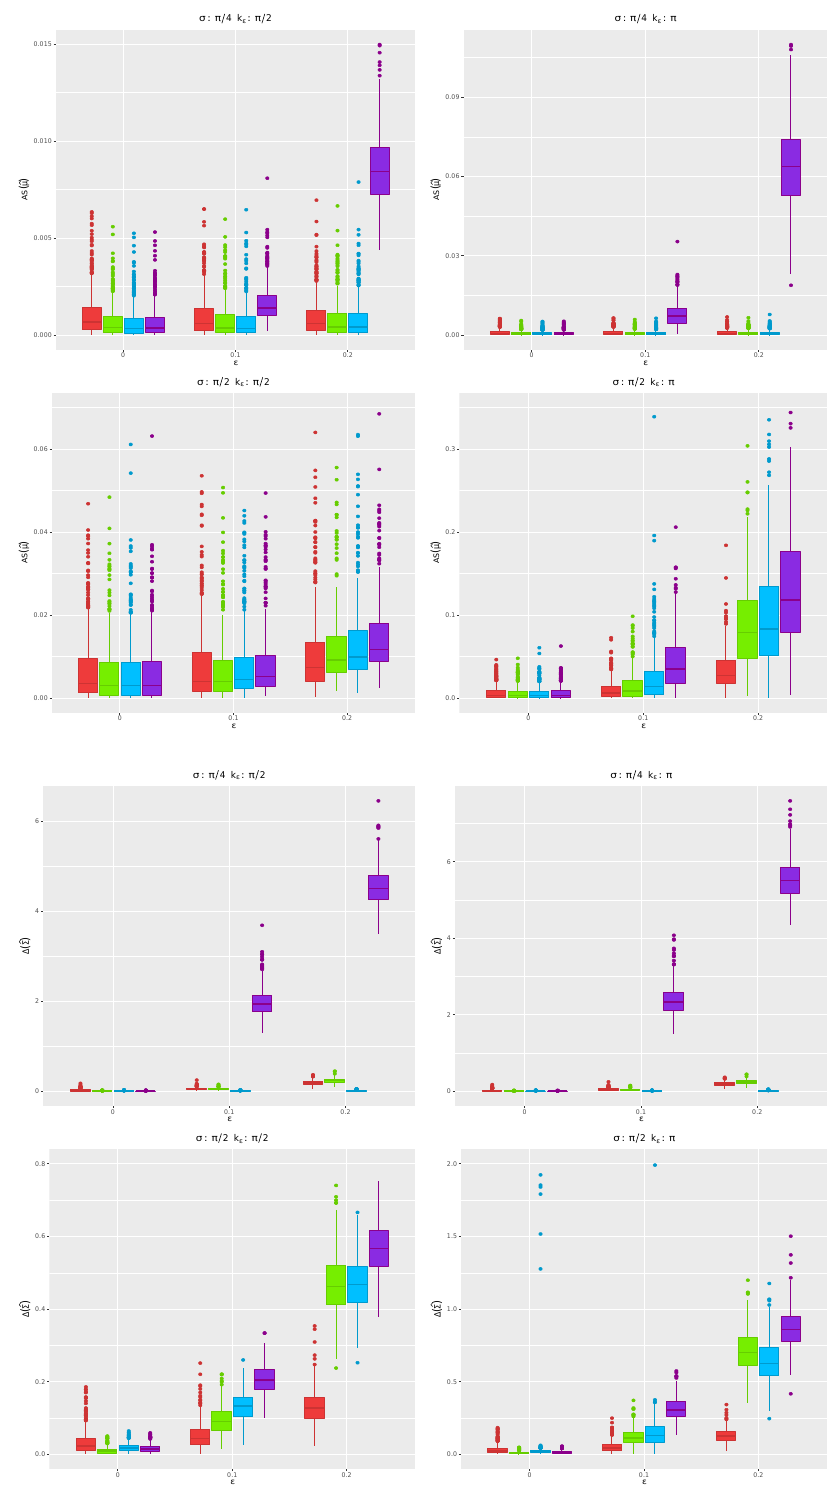
Figure 5. Boxplots of the angular separation ( top ) and divergence ( bottom ) values obtained using (from left to right) MCD (red), MM (green), WLE (blue), and MLE (violet) with respect to the contamination level (cid:101) , with p = 2 and n =